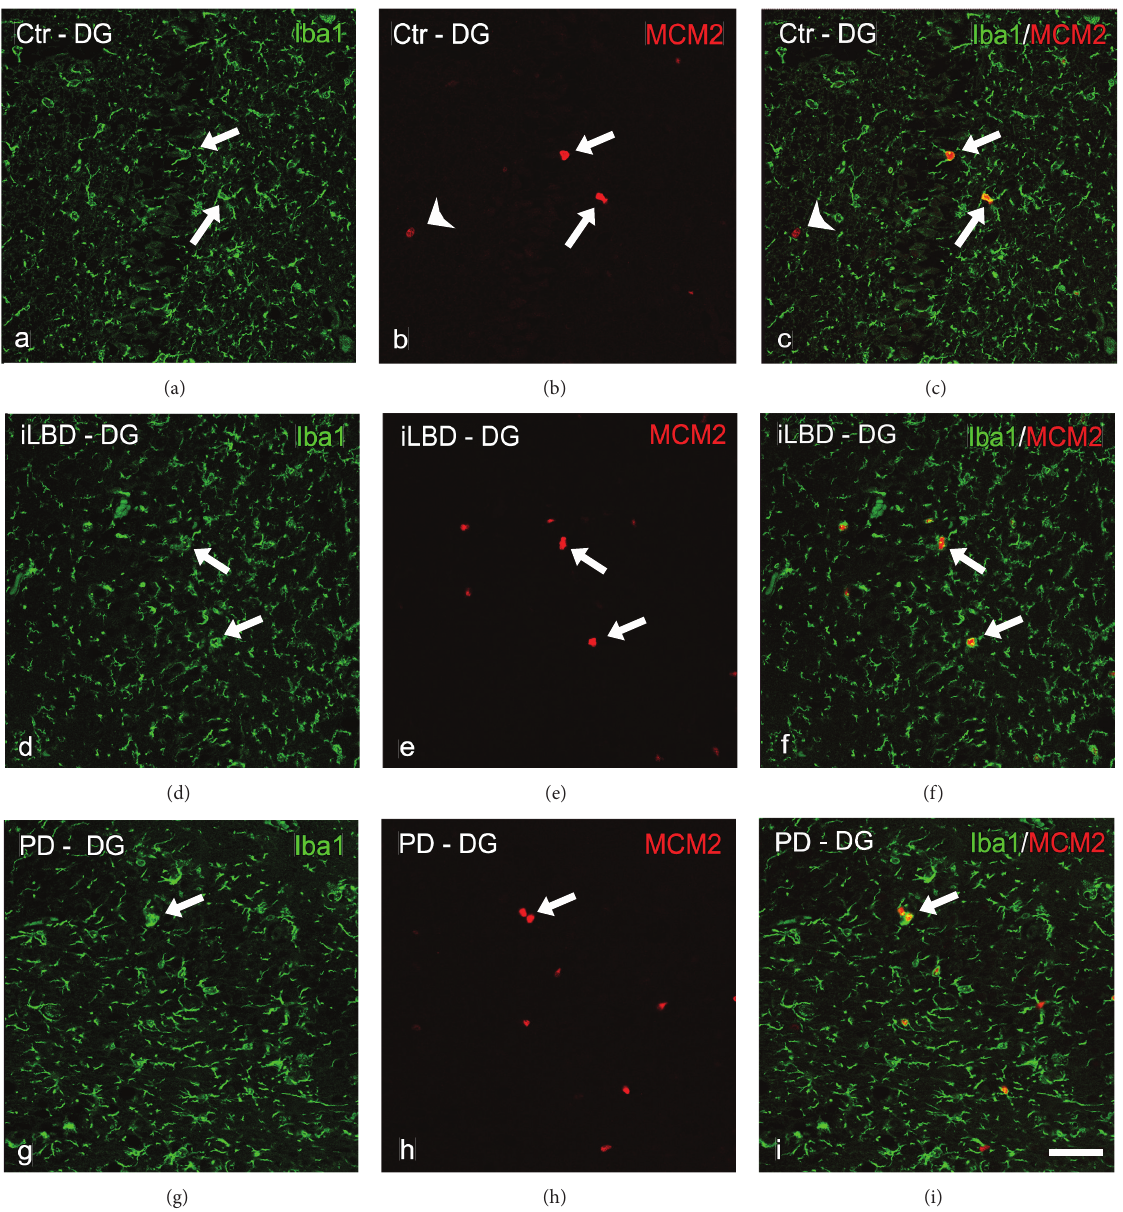
Figure 6: Colocalization of the majority of MCM2-positive cells with Iba1 in the hippocampal DG region of control subjects, iLBD cases, and PD patients. (a–f) Representative confocal laser scanning microscopical images of double-immunofluorescent stained sections revealed that the majority of the MCM2-positive cells show colocalization with the microglial marker Iba1 (arrows in (c), (f), and (i)). (b, d) Control subject shows one MCM2-positive cell with no colocalization with Iba1 (arrowhead). Iba1-positive microglia are depicted in green (a, d, and g) and MCM2 in red (b, e, and h); bar (a–i) = 40 𝜇